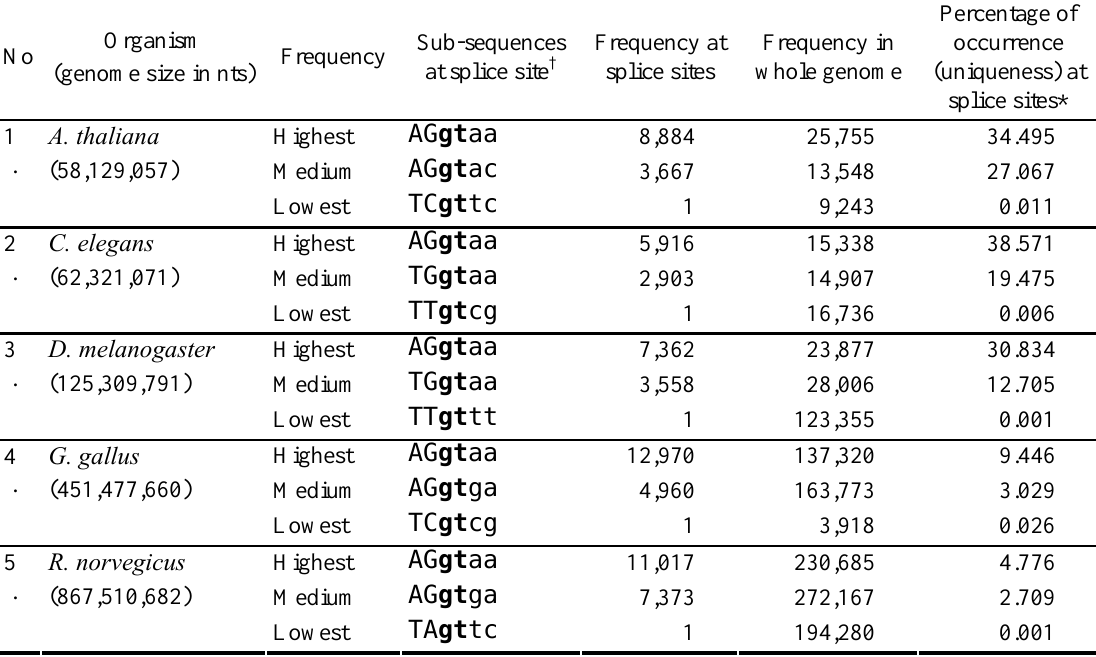
*The percentage of occurrence (uniqueness) values are normalized to three decimal points in order to represent even the lowest values. † The two central, highly conserved dinucleotides in the sub-sequences are shown in